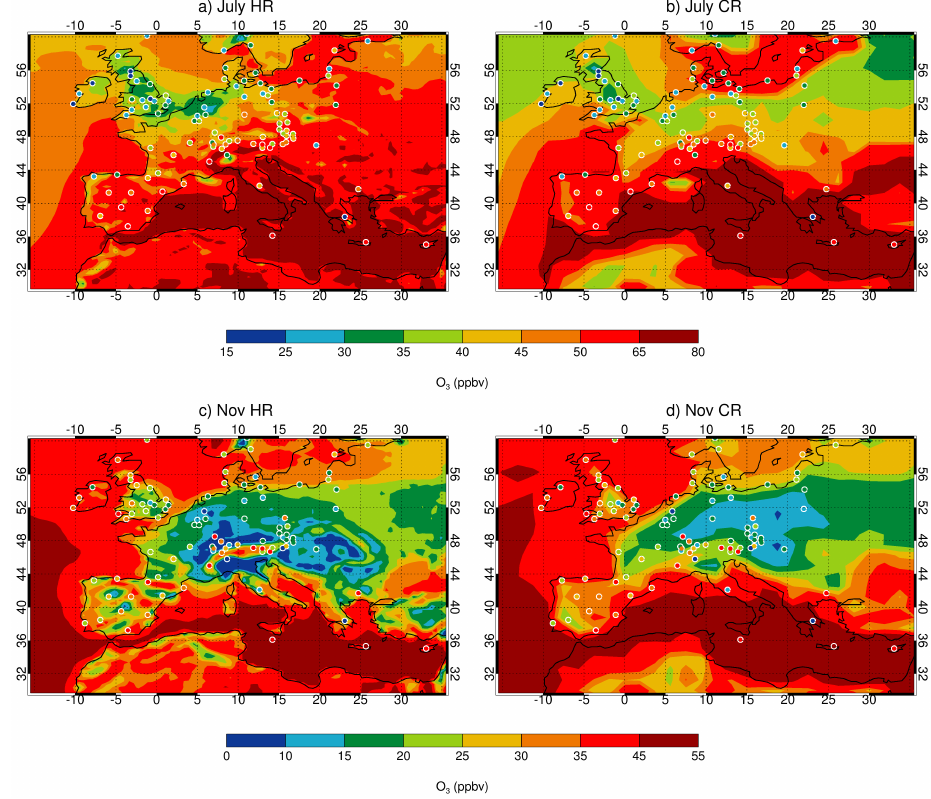
Fig. 3. Monthly mean surface ozone concentrations across Europe for CR and HR. Circles denote observations from the EMEP network.